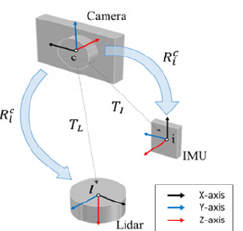
Figure 2. Demonstration of system mounting parameters A rigorous calibration strategy is developed which simultaneously calibrates both the lidar sensor and the system mounting parameters.